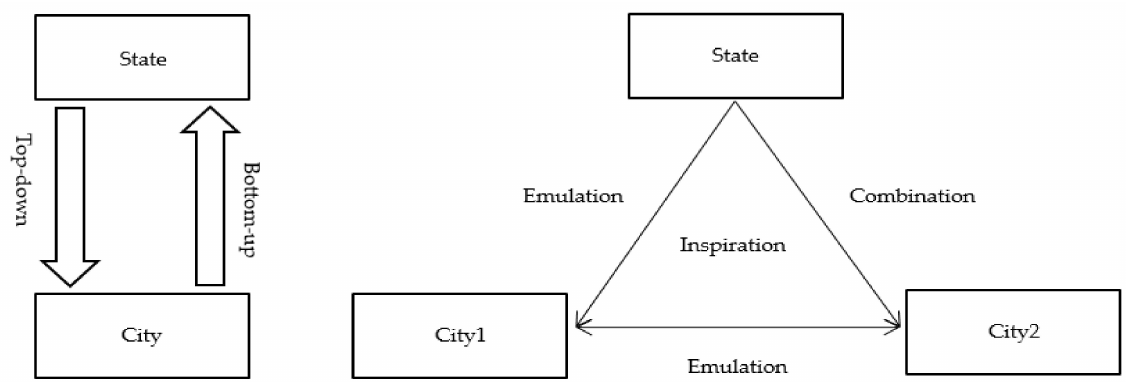
Figure 6. The degree of urban renewal policy transfer in